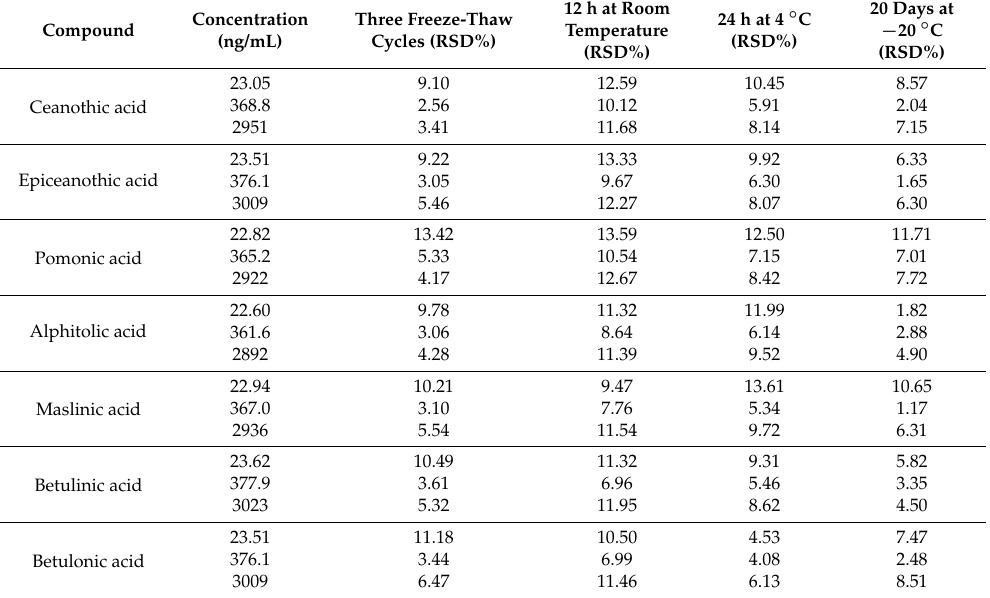
Table 4. Stabilities of the seven compounds in rat